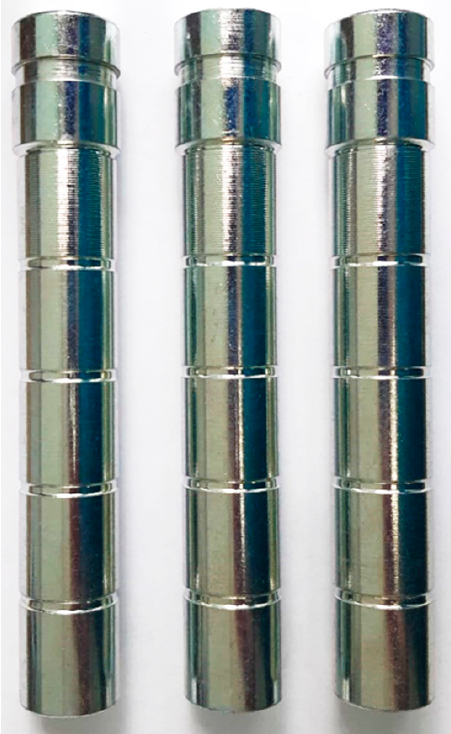
Coatings 2023 , 13 , x FOR PEER REVIEW Figure 3. Hot dip galvanized parts not immersed. Figure 3. Hot dip galvanized parts not immersed.